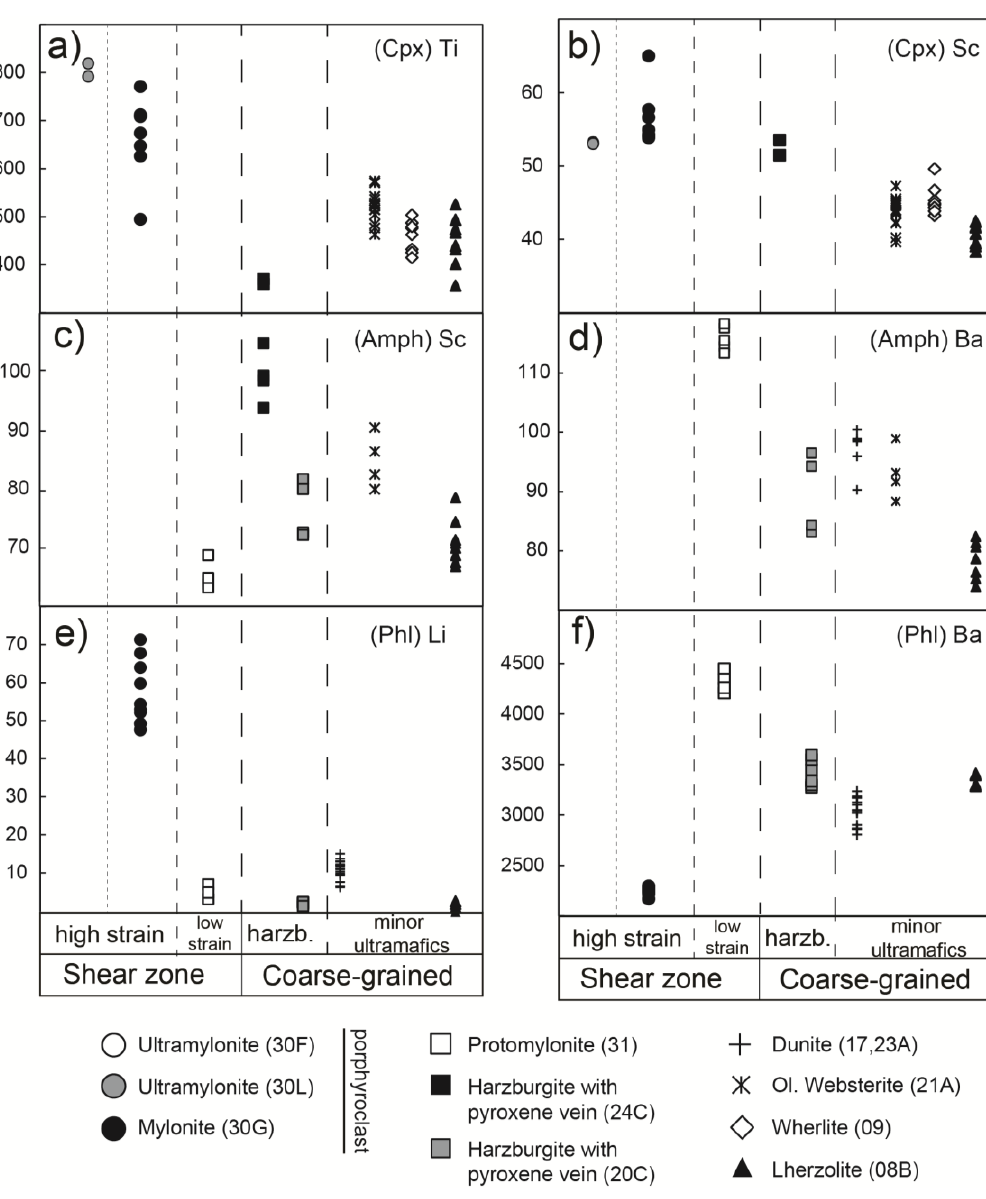
Figure 8. Trace-element concentrations (ppm) in mineral phases of Finero Ph-Pd samples. ( a , b ) Al, Sc content in clinopyroxene; ( c , d ) Sc, Ba content in amphibole; ( e , f ) Li, Ba content in phlogopite.